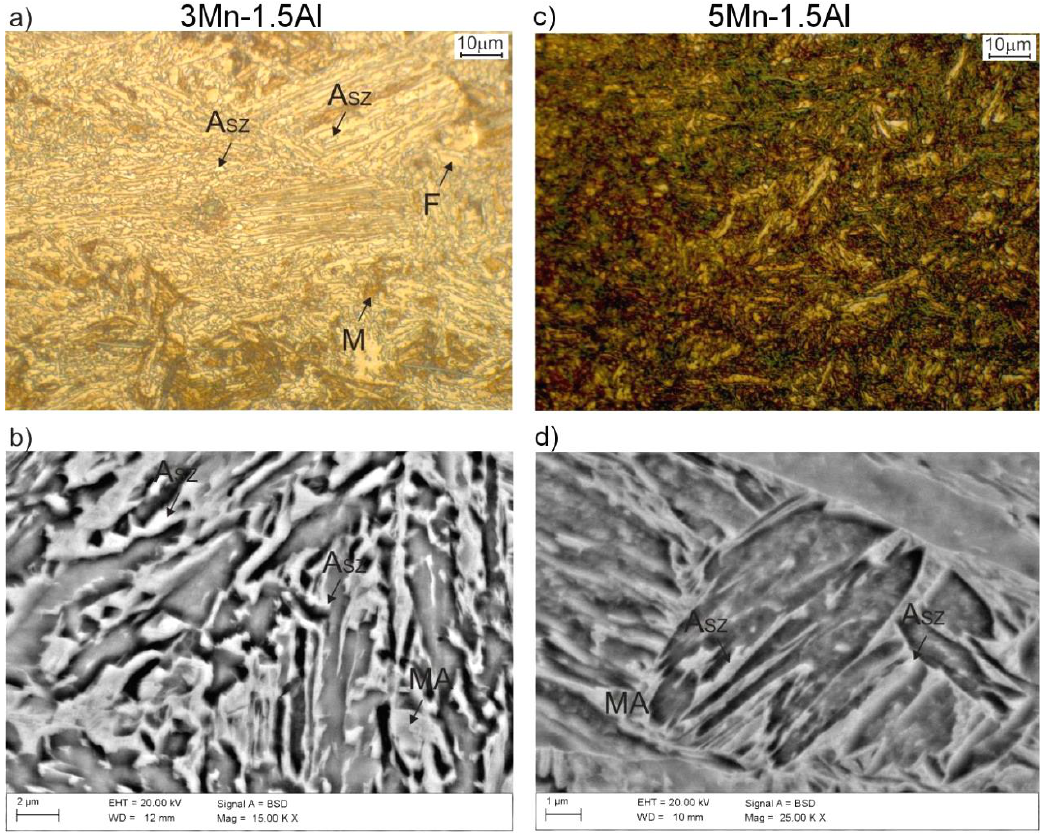
Figure 2. Bainitic microstructures with retained austenite and martensitic-austenitic constituents ( a , b ) ( a , b ) 3Mn-1.5Al steel, ( c , d ) 5Mn-1.5Al steel; F—ferrite, M—martensite, MA—martensite-austenite 3Mn-1.5Al steel, ( c , d ) 5Mn-1.5Al steel; F — ferrite, M — martensite, MA — martensite-austenite constituents, A SZ —retained constituents, A SZ — retained austenite.